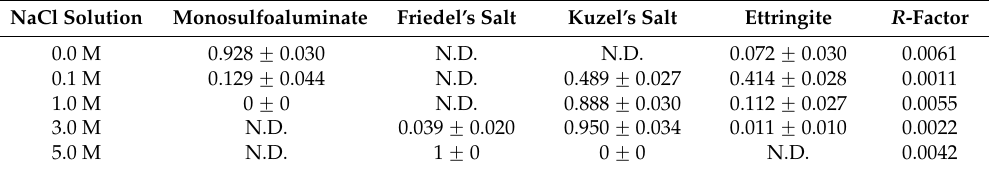
Table 2. Molar phase fractions determined from the LC fitting of Ca L III , II -edge XANES spectra. NaCl Monosulfoaluminate Solution